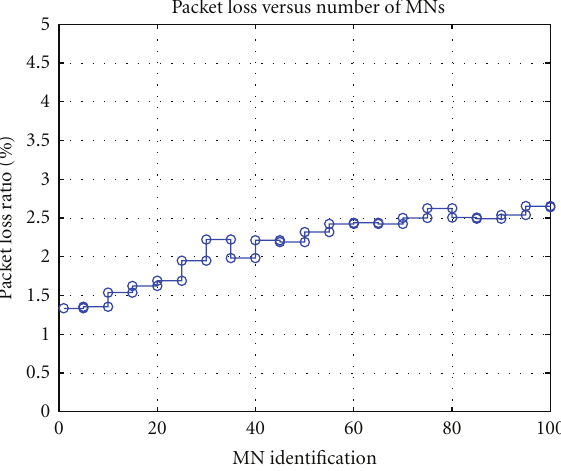
Figure 10: Percentage of packet loss versus no. of